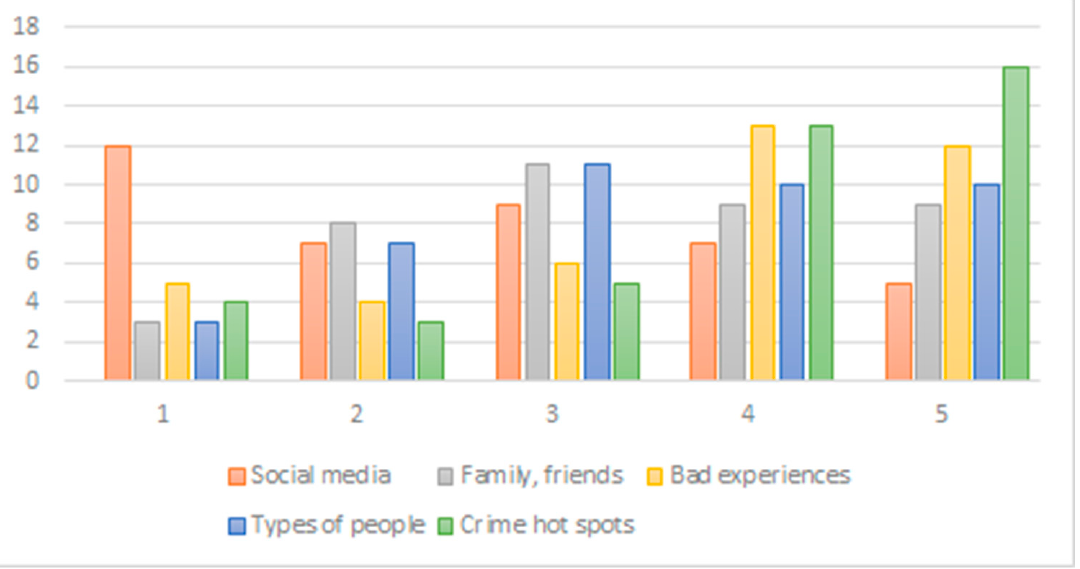
Figure 7. Categories influencing test participants’ crime perception from 1 (not at all) to 5 (most).